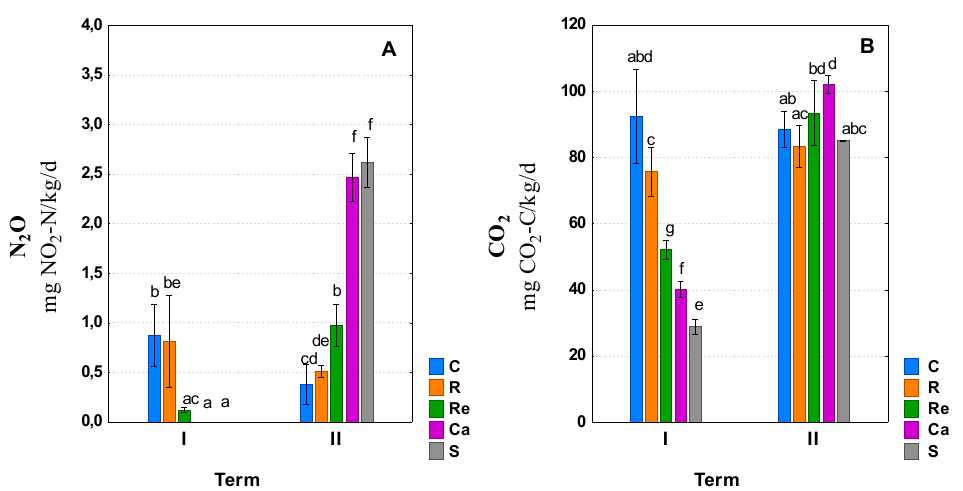
Figure 3. Greenhouse gases emissions from soil. Legend: ■ C-control (without pesticides), ■ R-herbicide Roundup, ■ Re-herbicide Reglone, ■ Ca-fungicide Caramba, ■ S-adjuvant Spodnam. A—nitrous oxide emissions , B—carbon dioxide emission